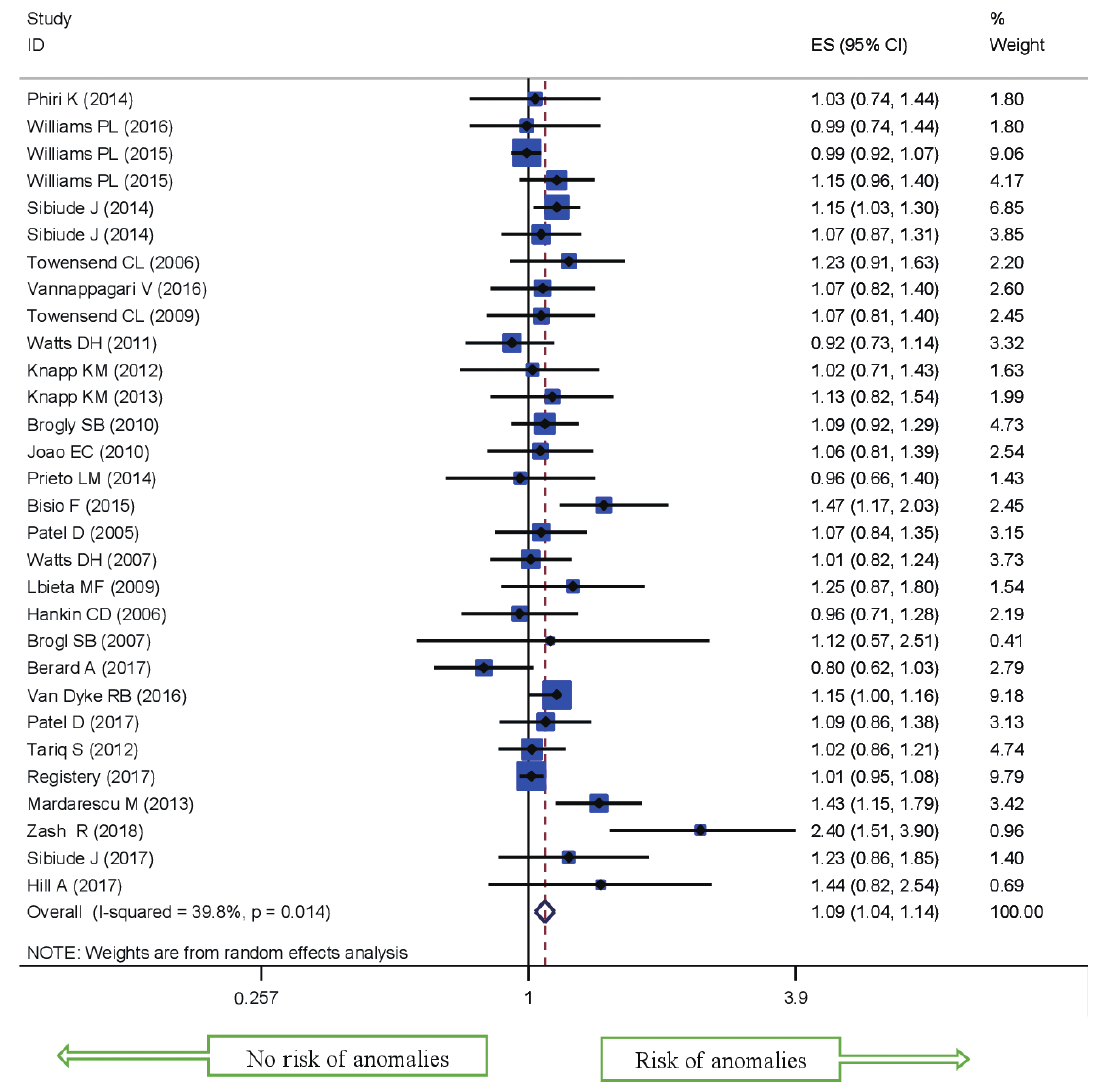
Figure 2. Meta-analysis of the effects of antiretroviral therapy (ART) on risk of congenital anomalies compared to ART-naïve individuals. ES, effect size; CI, confidence